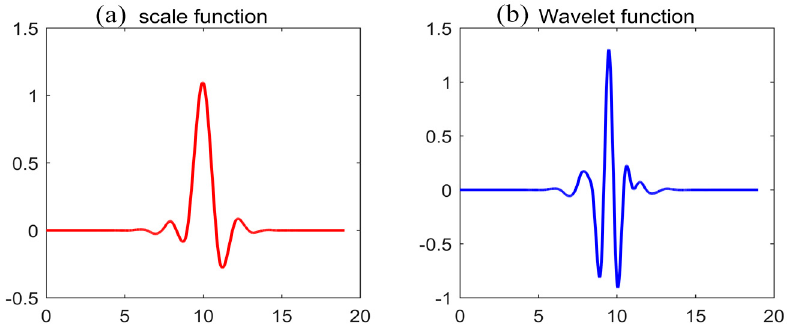
Figure 1. Scale function and wavelet function of Figure 1 . Scale function and wavelet function of Sym10.